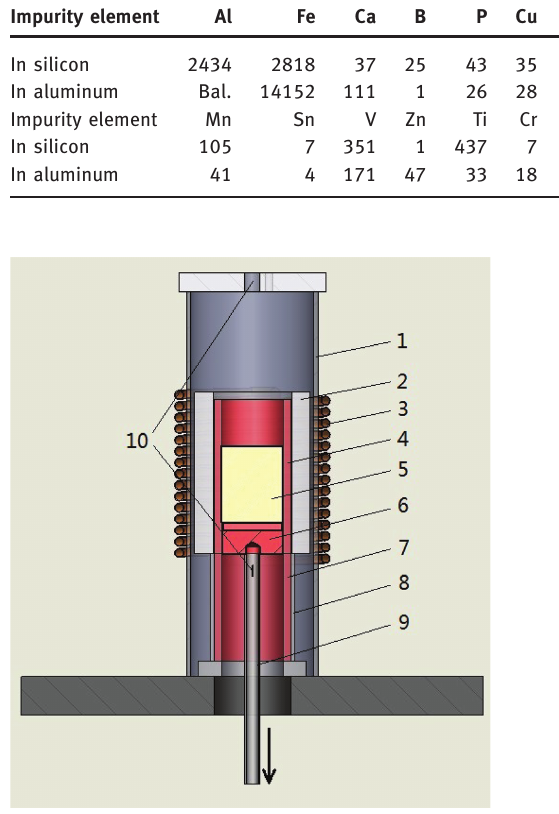
Figure 1: Schematic drawing of furnace 1 quartz tube; 2 thermal insulation tube; 3 induction coil; 4 graphite heater tube; 5 Al-Si melt; 6 graphite bottom support; 7 graphite tube; 8 quartz sup- porting tube; 9 stainless steel tube connected to pulling mechan- ism; 10 gas inlet.